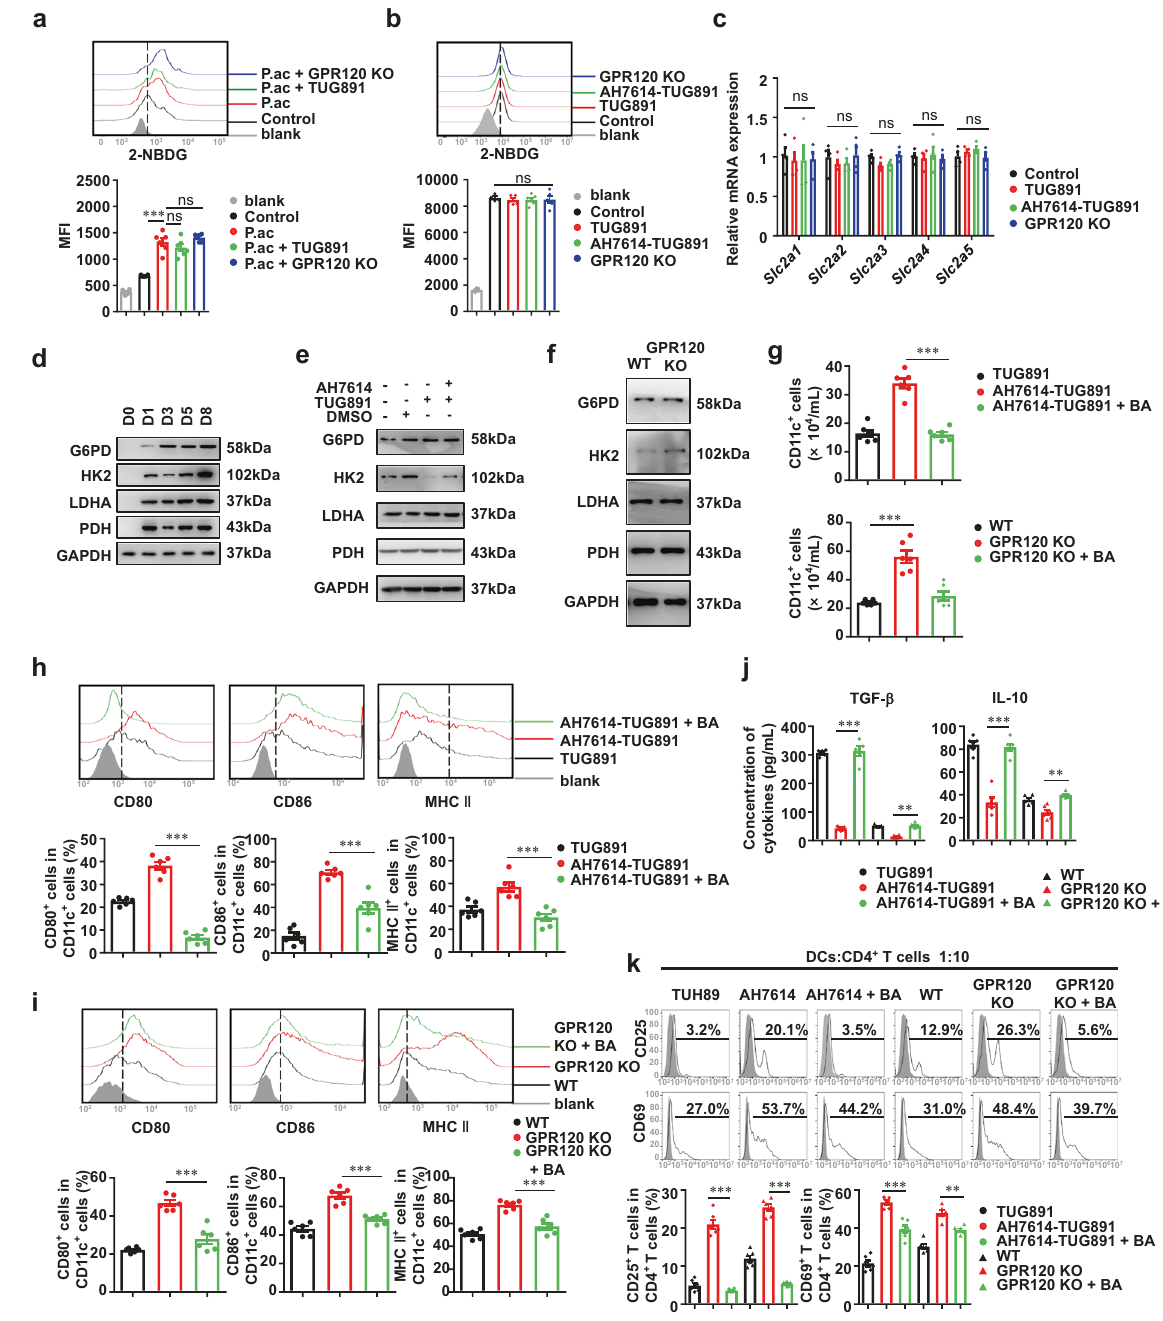
Fig. 6 GPR120 activation induced regulatory DCs by inhibiting glycolysis. a Wild-type (WT) and GPR120 − / − (GPR120 KO) mice were injected with P. acnes (P.ac). Vehicle or TUG891 (10 mg/kg) was administered i.p. to WT mice on days 0, 2, 4, and 6 after P. acnes injection ( n = 7 mice per group). Glucose uptake of CD11c + DCs in mouse livers was measured by 2-NBDG assay. Mean fl uorescence intensity (MFI) of 2-NBDG was shown. b – f BMCs from WT and GPR120 − / − mice were isolated and cultured to induce maturation. TUG891 (20 μ M) with or without AH7614 (20 μ M) pretreatment was added to the medium of BMCs from WT every 2 days. LPS (0.1 μ g/mL) was added on day 7. CD11c + cells were separated using magnetic cell sorting microbeads. b 2-NBDG was added, and glucose uptake was determined by fl ow cytometry. MFI of 2-NBDG was shown. c Quantitative real-time PCR was used to determine the mRNA expression of Slc2a1-5 in DCs on day 8. d , f Protein expression of G6PD, HK2, LDHA, and PDH in DCs was determined by immunoblot analysis during DC maturation or with GPR120 interference on day 8. g – k The glycolysis inhibitor bromopyruvic acid (BA, 5 μ M) was added to the DC induction medium. g The numbers of CD11c + DCs among the cultured cells were analyzed by fl ow cytometry on day 8. h , i The expression of CD80, CD86, and MHC II of CD11c + DCs was analyzed by fl ow cytometry on day 8. j Levels of TGF- β and IL-10 were measured by enzyme-linked immunosorbent assay. k CD4 + T cells were cocultured with DCs that underwent the indicated treatments for 16 h. CD25 and CD69 expression in CD4 + T cells was analyzed by fl ow cytometry. The results are representative of three to six independent experiments and presented as the mean ± SEM. Signi fi cant differences were analyzed by One-way ANOVA. ** p < 0.01, *** p < 0.001, ns no signi fi cance.